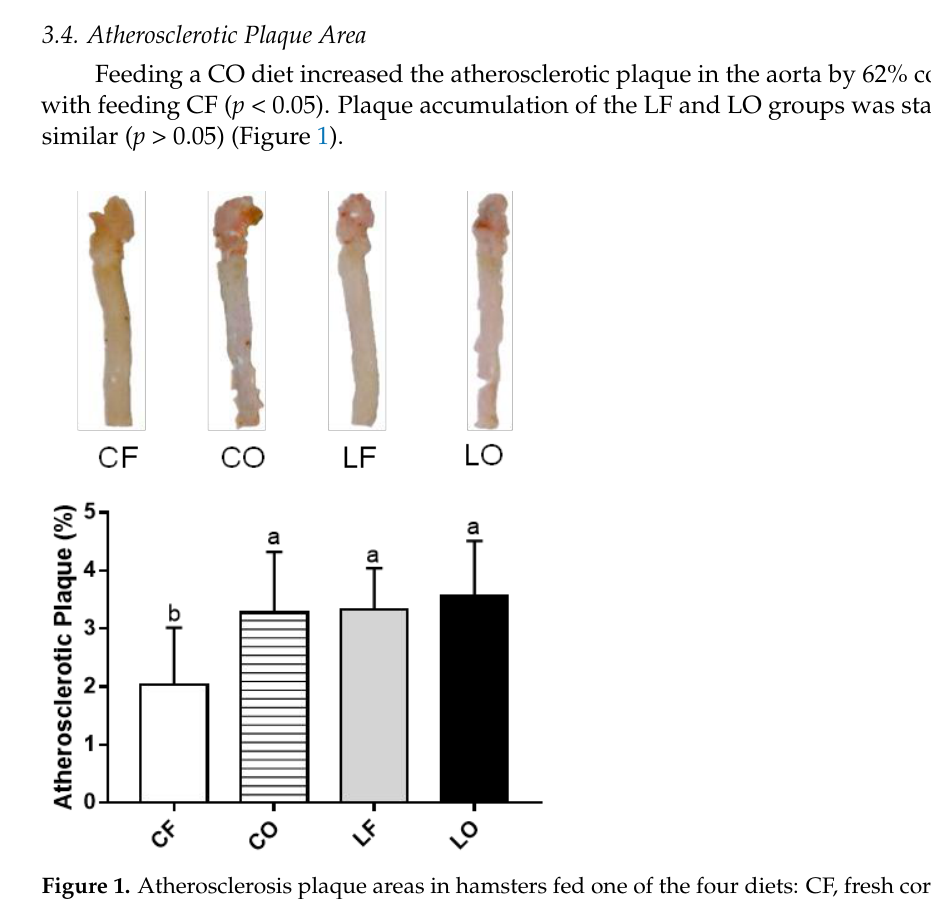
Figure 1. Atherosclerosis plaque areas in hamsters fed one of the four diets: CF, fresh corn oil; CO, oxidized corn oil; LF, fresh lard; LO, oxidized lard. Data are expressed as mean ± S.D., where different letters indicate statistical difference, p < 0.05.